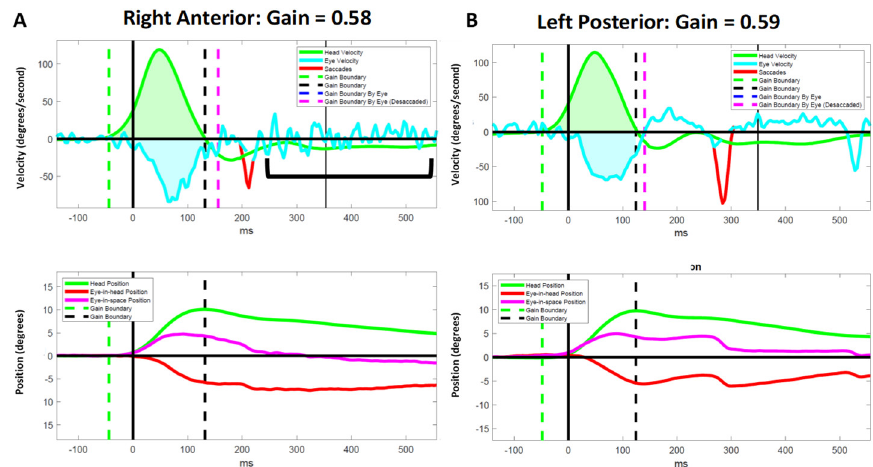
Figure 2. Representative results for a participant with moderate MS who demonstrated an exacerbation of vertical nystagmus [bracket] following right-anterior impulses, but not left-posterior impulses. The presence of nystagmus was confirmed by reviewing the video recording of their vHIT (see supplemental material). Data for the right anterior ( A ) and left posterior ( B ) canals are shown in the velocity (upper panel) and position (lower panel) domains. ms = milliseconds.